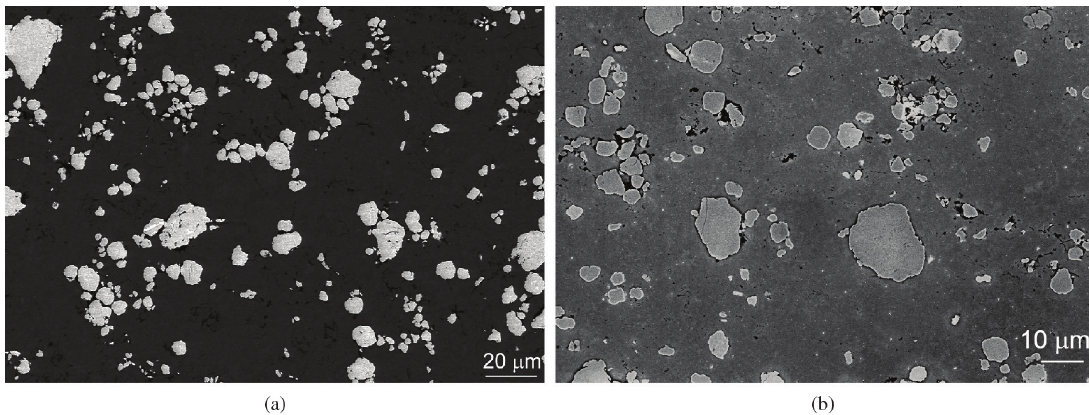
Figure 1. SEM images showing FeAlCr particles distribution in the as extruded condition. (a) image obtained by back-scattered electron contrast; (b) image obtained by secondary